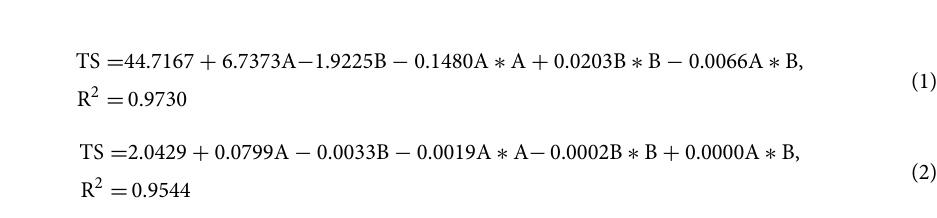
Table 4. ANOVA result on tensile modulus (TM). SS sum of squares, MS mean square.